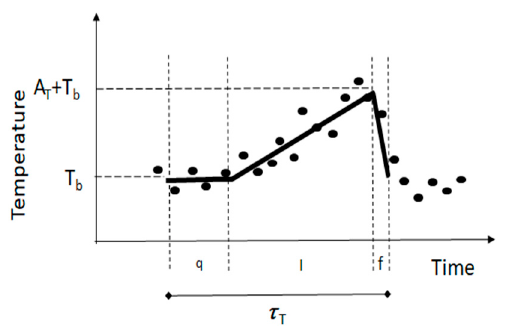
Figure A1. Time course of the temperature of the air measured at high frequency (dot) for an unstable case. T b is a baseline temperature representing the mean temperature of a parcel of air that descended to the surface. Quiescent (q), gradual warming (l) and ejection (f) phases are distinguished while the air parcel remains in contact with the surface for a period τ T . Ideally, the mean temperature time course of the air parcel during each phase is assumed linear showing a ramp-like shape in the trace (signature of a coherent structure characterized by a ramp amplitude, A T , and period τ T ). ( A T + T b ) represents the mean temperature of the air parcel when it was renewed.